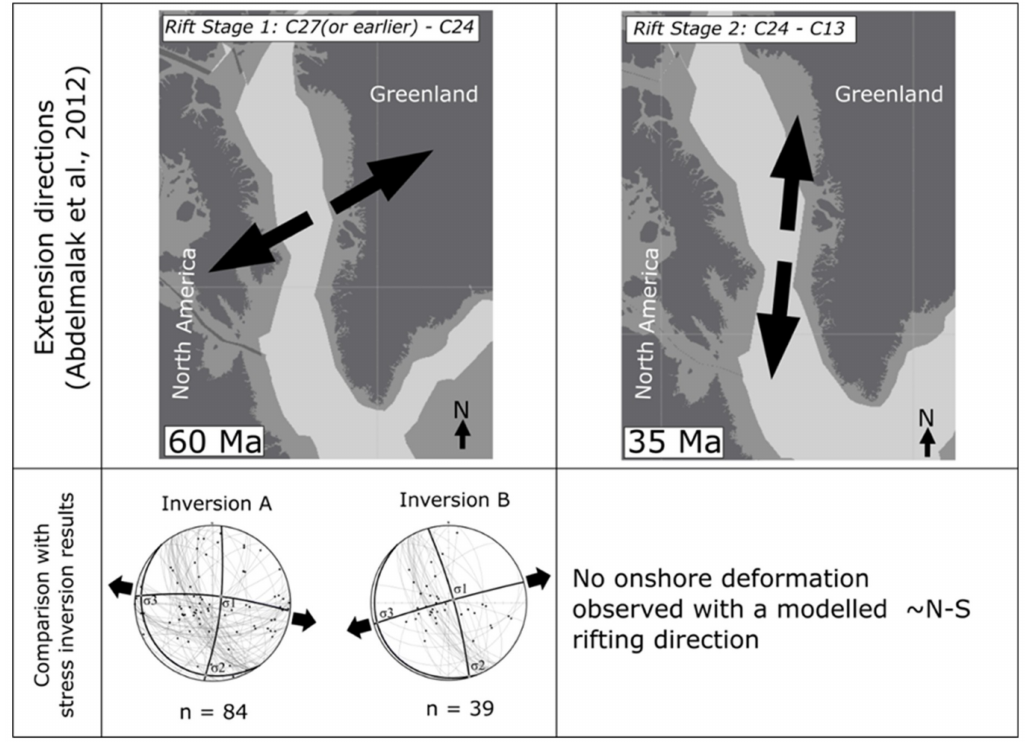
Figure 16. Comparison between the stretching directions in [8] and the stretching direction ( σ 3) produced by the inversions in this study. In addition, the results of the geopotential stress field analysis reproduce a comparable direction for stage 1 but do not resolve stage 2